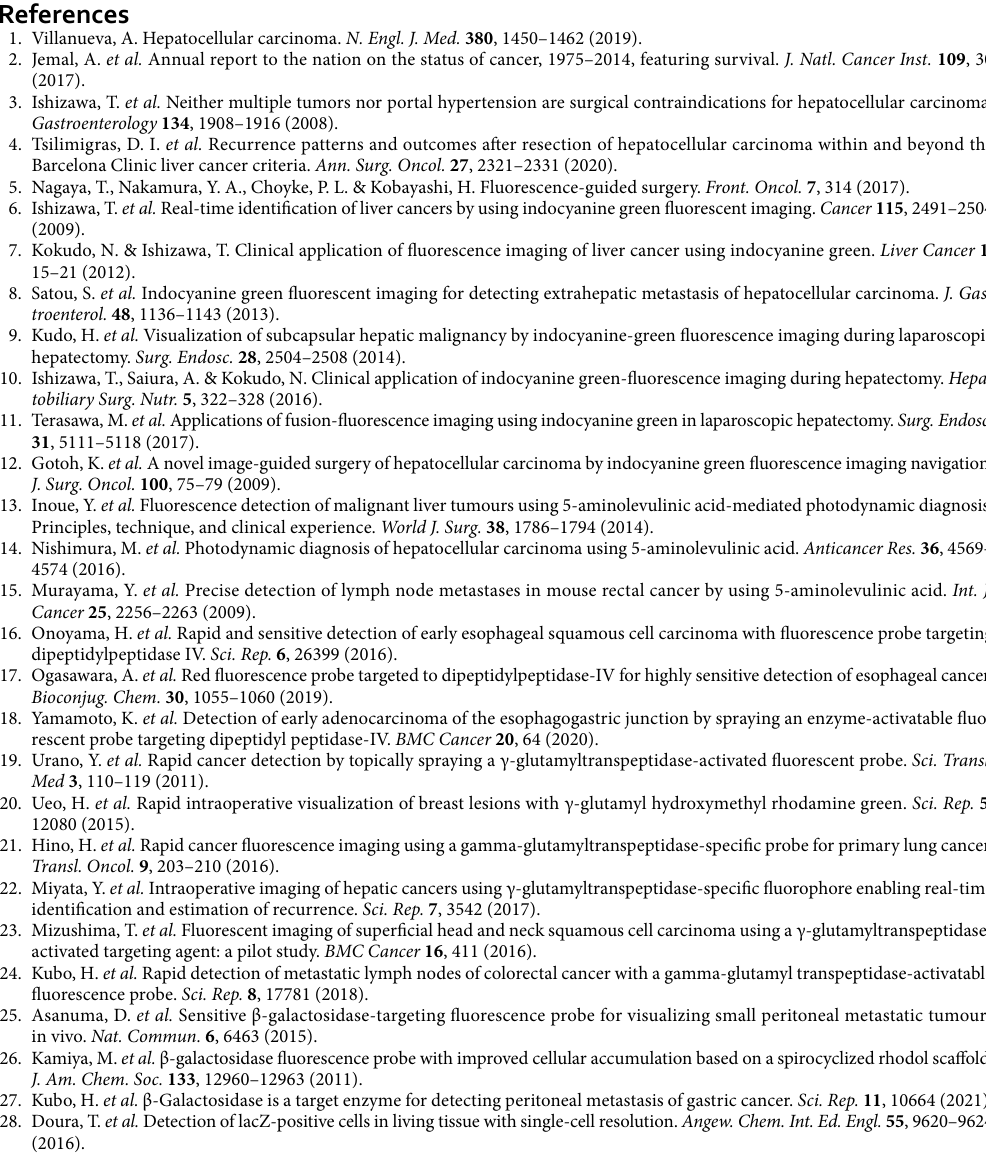
Figure 4. Fluorescence imaging and diagnostic potential of freshly resected human hepatocellular carcinoma (HCC) specimens. ( a ) Representative fluorescence images (case 22) obtained after spraying the specimens with 50 μM SPiDER-βGal, captured using IVIS Lumina Series III (Excitation: 520 nm, Emission: 570 nm). Scale bar = 10 mm. Guide map (white light): The areas surrounded by the red lines indicate the tumour (right). ( b ) Time-dependent changes in fluorescence intensities of tumour and non-tumour tissue after spraying SPiDER- βGal (50 μM) (case 22). ( c ) Box-and-whisker plot of time-dependent changes in fluorescence intensities of the tumour (blue) and non-tumour (green) tissues after spraying 50 μM SPiDER-βGal (HCC, n = 27). Means (cross), medians (horizontal line within box), inter-quartile ranges (box), and ranges (error bars) are indicated. The median fluorescence intensity of the tumour tissues was significantly higher than that of non-tumour tissues after 2 min of spraying SPiDER-βGal (50 μM). * p < 0.05, ** p < 0.01. A two-tailed Wilcoxon t -test was used. ( d ) Receiver operating characteristic (ROC) curves of the increase in fluorescence intensities from 0 to 10 min. The yellow line is a 45° straight line tangent to the ROC curve. ( e ) ROC curves of the increase in fluorescence intensities from 0 to 30 min. The yellow line is a 45° straight line tangent to the ROC curve.